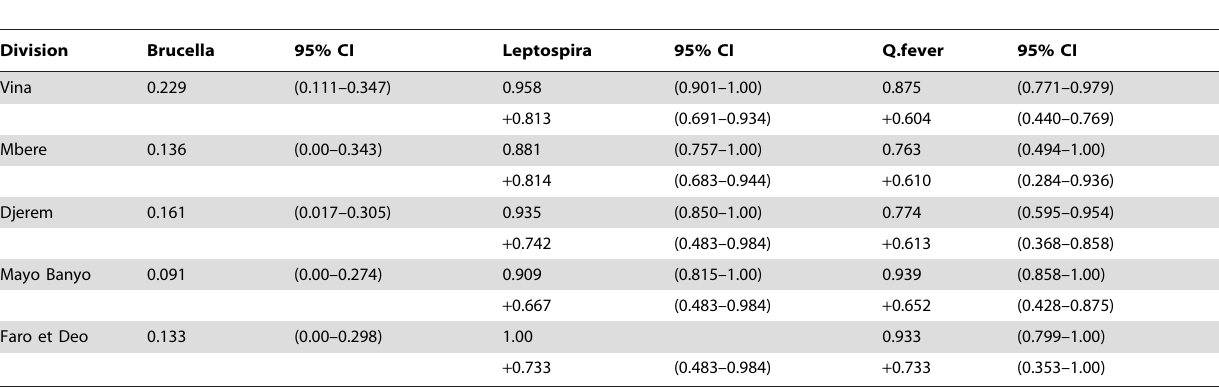
Table 3. Herd-level ( P herd ) apparent Divisional seroprevalences (with 95% confidence intervals adjusted for study design effects) for cattle in the Adamawa Province of Cameroon to Brucella spp. , Leptospira Hardjo and Q